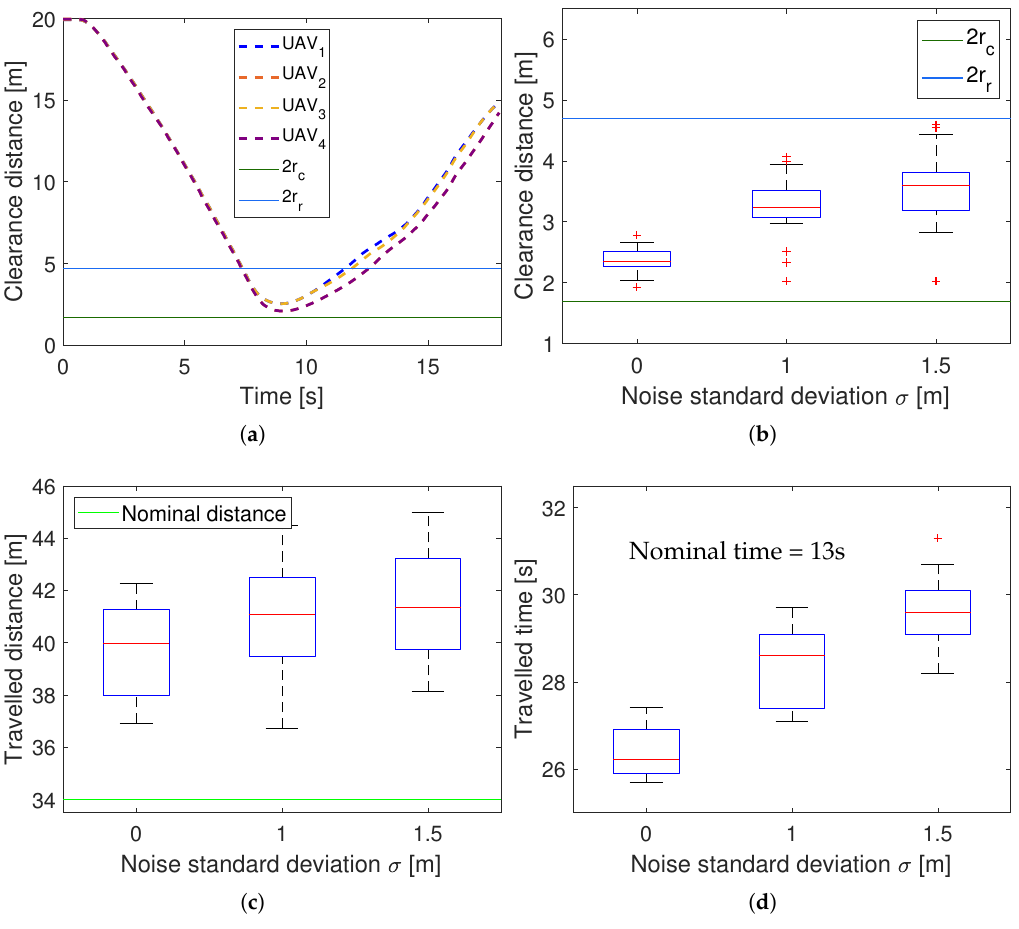
Figure 6. 3D-SWAP results in simulations increasing noise in observed positions. ( a ) Clearance distance along time for a simulation run without noise. The distance 2 r r indicates when UAVs enter in xy-conflict, and the distance 2 r c when they collide. ( b ) Boxplot comparing clearance distances as noise increases. ( c ) Boxplot comparing traveled distances as noise increases. ( d ) Boxplot comparing traveled times as noise